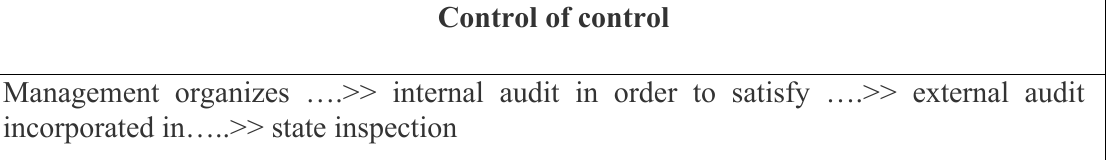
Table 2. The ritual of Audit Society (according to Michael Power) Control of